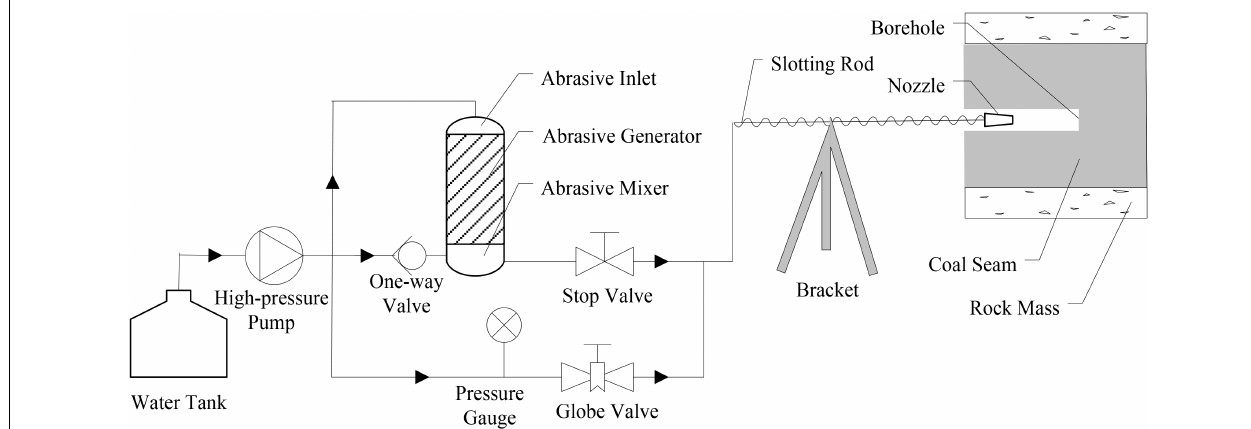
FIGURE 3 | Schematic diagram of the HPAWJF system.